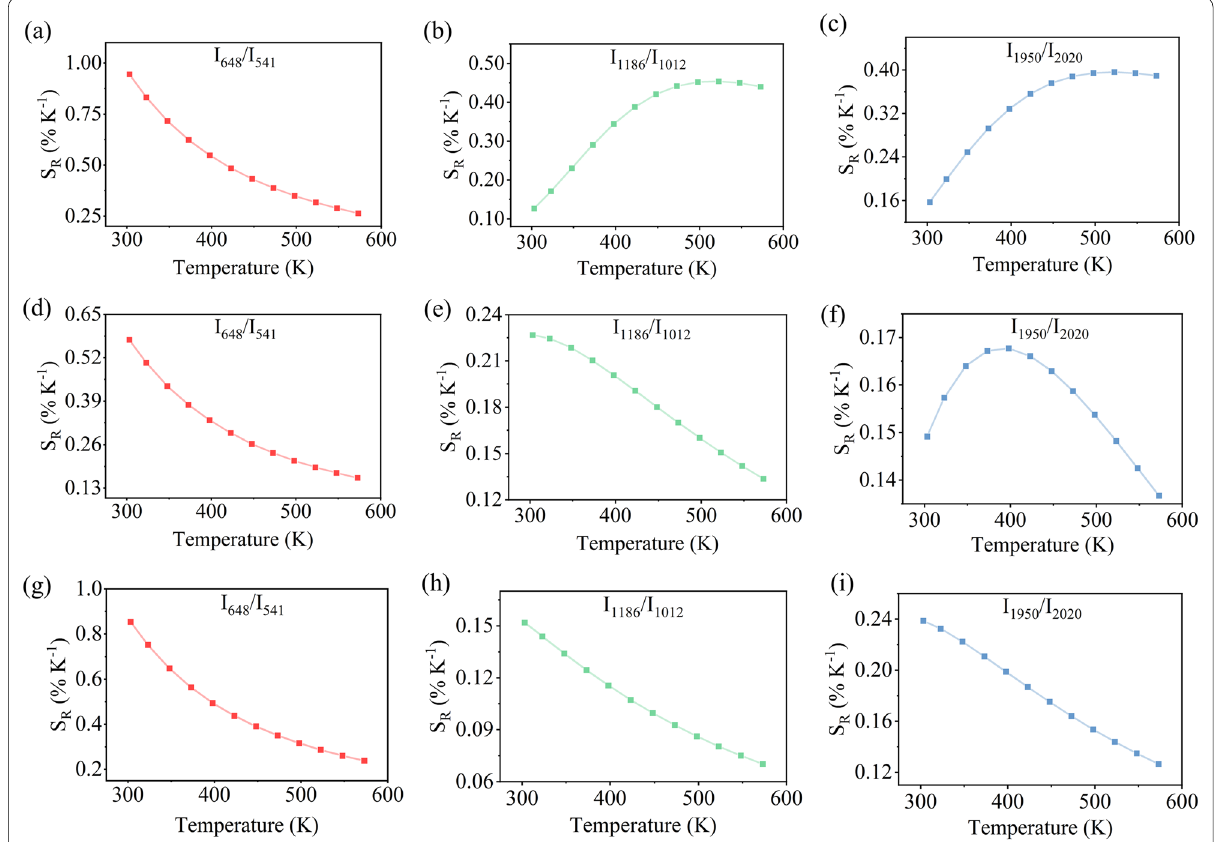
Fig. 8 The relative sensitivity S R versus temperature of SrF 2 :Yb 3 + /Ho 3 + (12/0.1 mol%) NCs under the excitation of a – c 980 nm, d – f 940 nm and g – i 915 nm, respectively